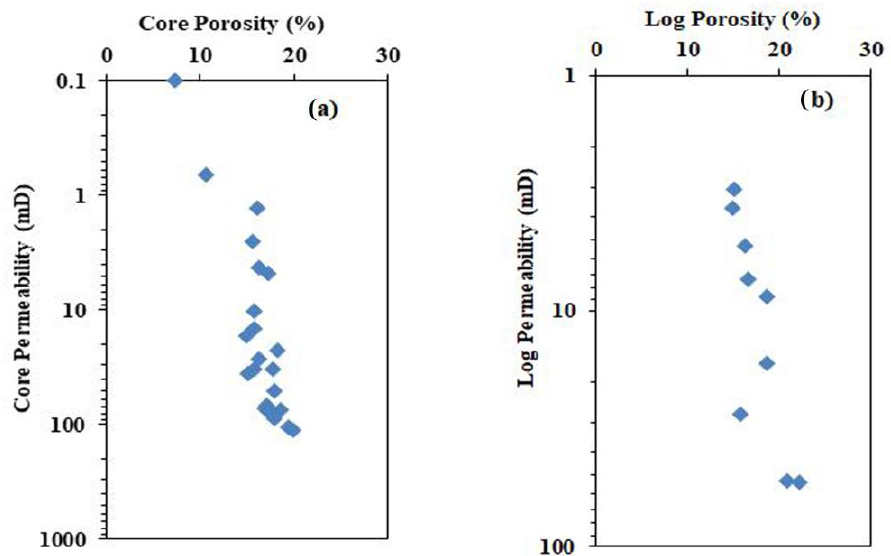
Figure 7. Relationship between ( a ) core permeability vs. core porosity (%); ( b ) log permeability (mD) vs. log porosity (%) of Srikail-3 well.